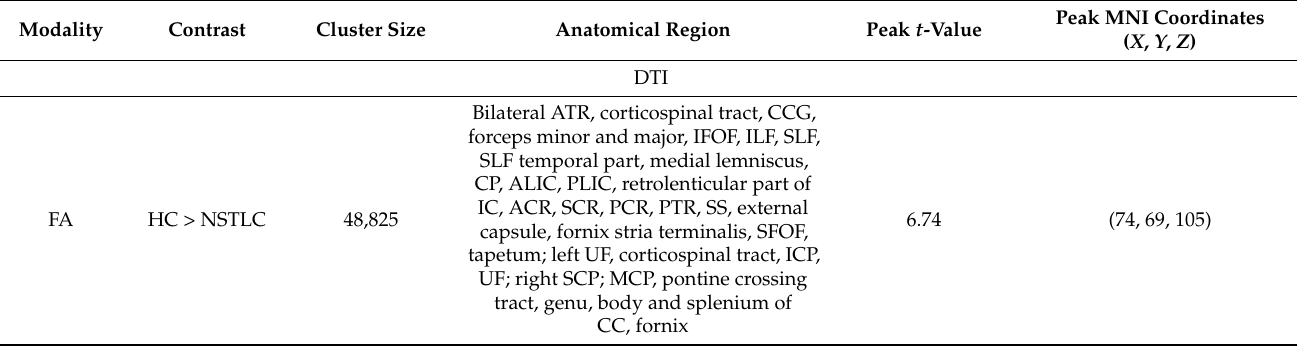
Figure 3. Comparison of TBSS of DTI among hemodialysis patients treated with NSTLC and with LTLC and healthy controls. Comparisons of DTI (FA, ( A ); AD, ( B ); RD, ( C ); and MD, ( D )) indices among hemodialysis patients treated with NSTLC and LTLC and healthy controls are shown. TBSS analyses show that hemodialysis patients treated with NSTLC have significantly lower FA and significantly higher MD, AD, and RD than healthy controls ( p < 0.05, ( A – D )), whereas there are no significant differences between hemodialysis patients treated with NSTLC and LTLC, and hemodialysis patients treated with LTLC and healthy controls (data not shown). The skeleton is presented in green. To aid visualization, the results are thickened using the fill script implemented in the FMRIB Software Library. AD, axial diffusivity; DTI, diffusion tensor imaging; FA, fractional anisotropy; LTLC, long-term L -carnitine treatment; MD, mean diffusivity; NSTLC, no or short-term L -carnitine treatment; RD, radial diffusivity; TBSS, tract-based spatial statistics. Table 2. Tract-based spatial statistics analysis of diffusion tensor and diffusion kurtosis imaging and neurite orientation dispersion and density imaging in hemodialysis patients and healthy